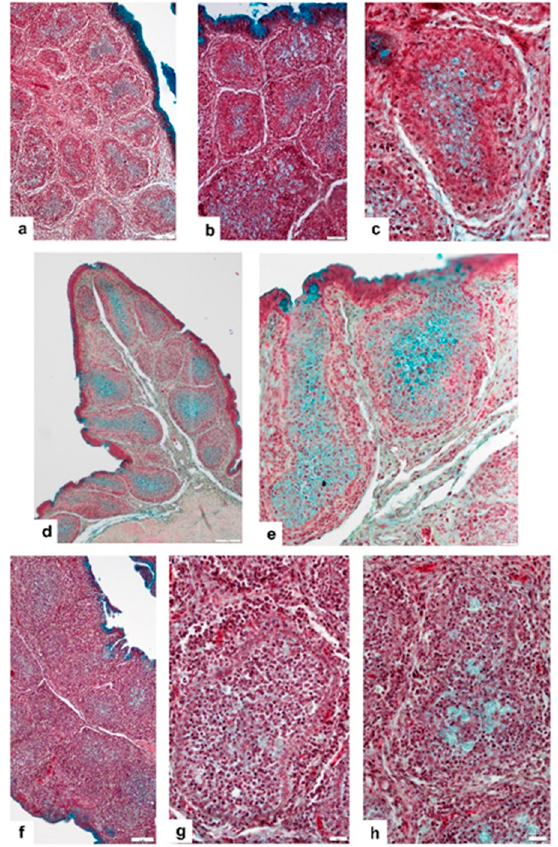
Figure 4. Vaccinated, non-challenged (V-NC) group of chickens sampled at D31 (3 dpv) ( a – c ) and at D35 (7 dpv) ( d , e ), representing the acute phase and the chronic stage of onset of vaccine virus replication, respectively. ( a ) The follicles are closely packed in the fold and the medulla contains many Movat stained Mal. ( b ) The surface epithelium of the fold is moderately wavy, mucin (gp) is found only in most apical part of IFE cells. Some follicles maybe had a small amount of extracellular gp. ( c ) The major part of CMEA consists of cuboidal-shaped epithelial cells. The cortex is thin and depleted. ICT moderately increased. ( d ) The most remarkable finding is the presence of extracellular gp in the follicles. ( e ) Higher magnification shows that in some places, the CMAE is well-retained, contains BSDC precursors (arrows). ( f – h ) Vaccinated, challenged (V-C) group of chickens. ( f ) The fold is densely packed with shrunken follicles, otherwise the histological structure is similar to that of the chronic stage group of birds. ( g ) The cells of CMAE transformed to cuboidal-shaped epithelial cells (arrow). In the medulla, several moderately stained, Movat-positive Mal(s) may be found. ( h ) The follicles have few aggregated Movat-positive Mal(s), but generally their number is lower than in the vaccine-take (V-NC) birds.